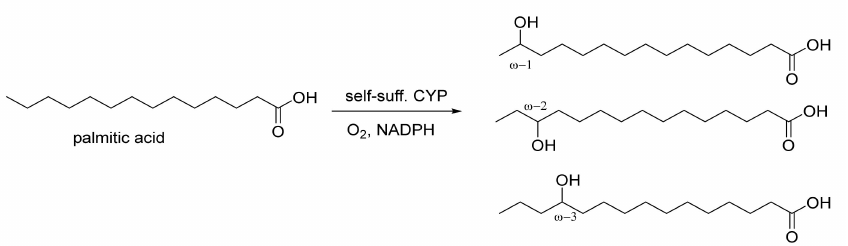
Scheme 1. Representative reaction of self-sufficient CYPs with palmitic acid, demonstrating most common HFA products. NADPH; nicotinamide adenine dinucleotide